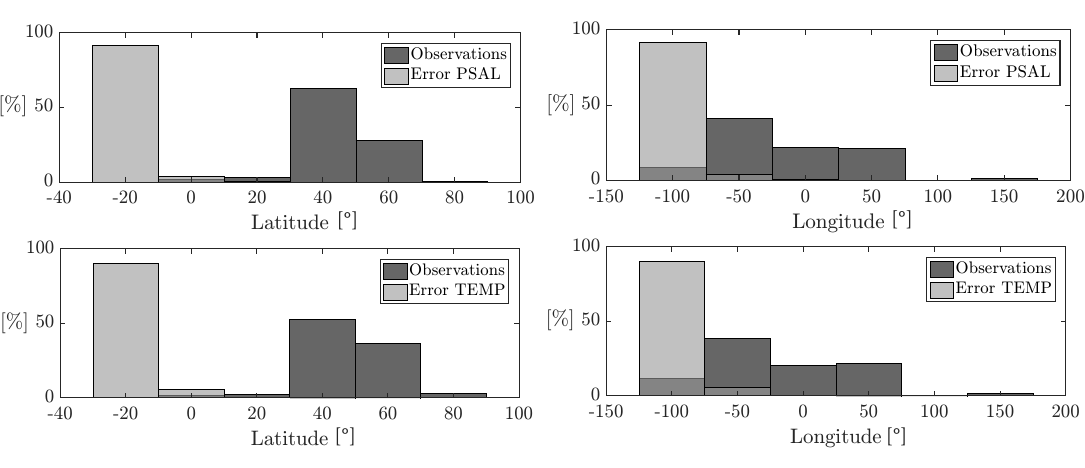
Figure 8. Histogram of number of observations and errors ( error = | Predicted − Observed | ) for salinity ( top panels ) and temperature ( bottom panels ). Left panels show latitude and right panels longitude.